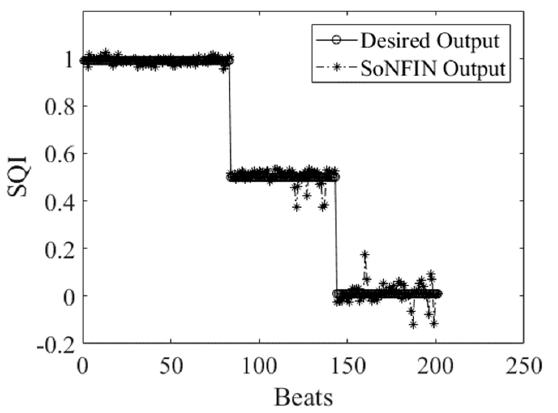
Table 1. The results of SoNFIN classification in the training phase.